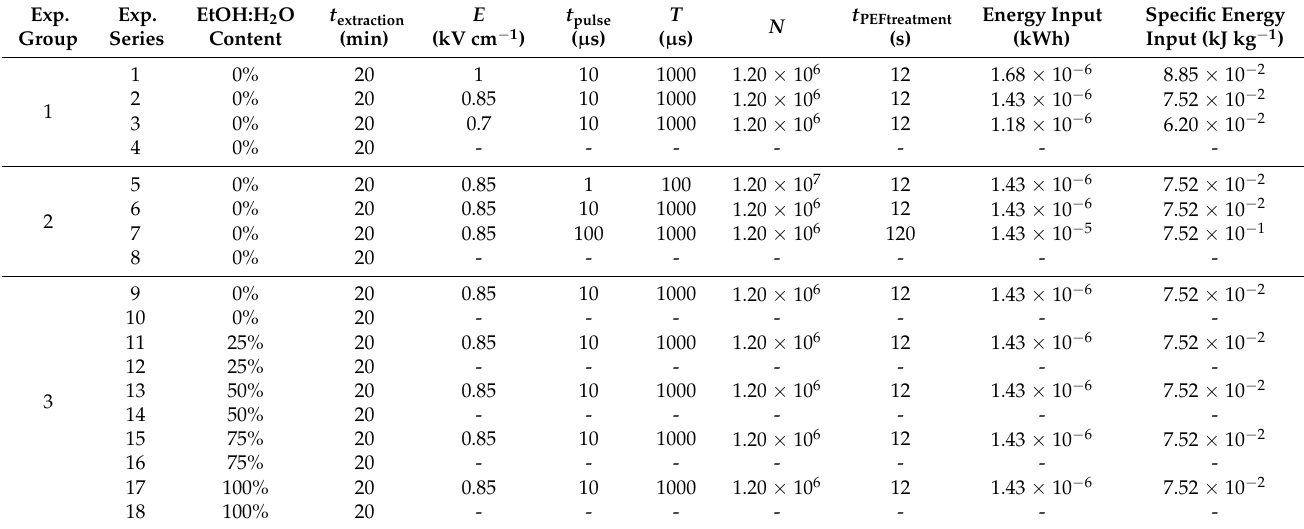
Table 1. Design of the PEF process optimization research; “-” denotes no values for control samples (no PEF